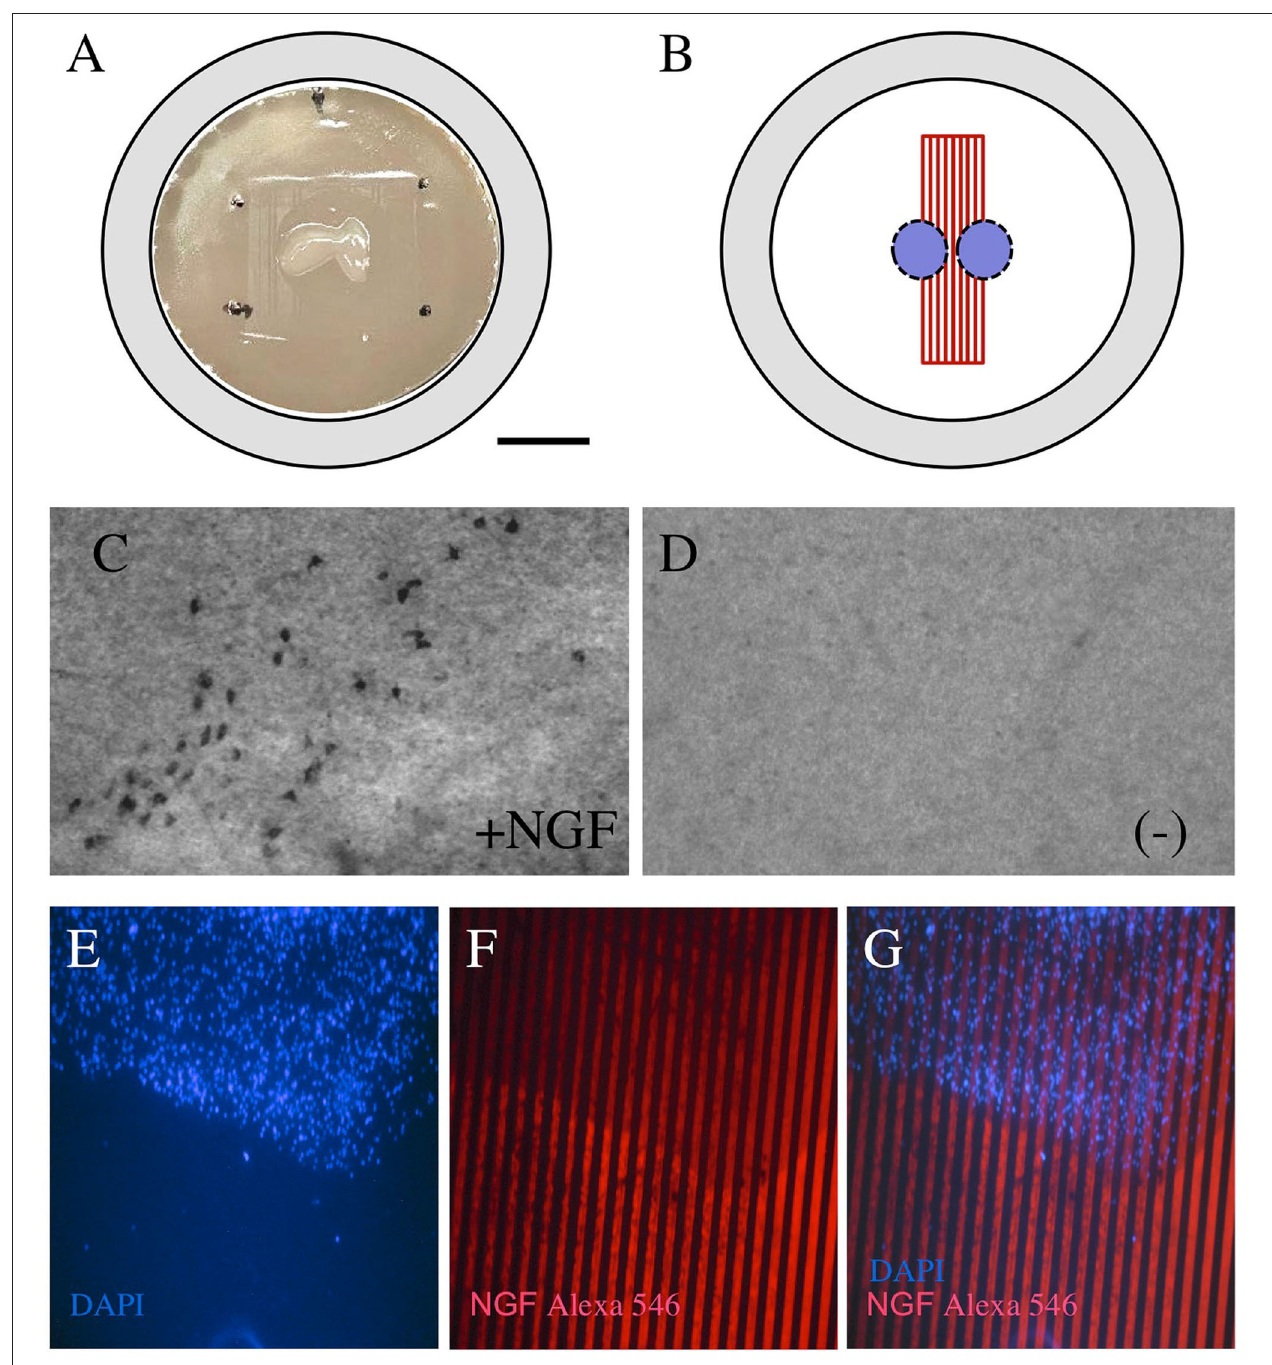
FIGURE 3 | Coupling of brain slices to microcontact prints. Chopper brain slices (300 µ m) were prepared from the basal nucleus of Meynert (nBM) and cultured on semipermeable membrane inserts (A) . The slices were coupled with the µ CP of NGF (B) . After 2 weeks in culture, the cholinergic neurons were stained for choline acetyltransferase (ChAT) and many cholinergic neurons survived when incubated with 100ng/ml NGF in the medium (C) , while no cholinergic neurons were visible when incubated without NGF (D) . The brain slices were stained for nuclear 4 ′ ,6-diamidino-2-phenylindole (DAPI) [ (E) , blue] and were connected to the NGF µ CP (stained by anti-NGF Alexa-546, red), showing that the slice grows directly in connection with the µ CP. Scale bar in A = 500 µ m (A) , 130 µ m (C,D) , 250 µ m (E–G) .